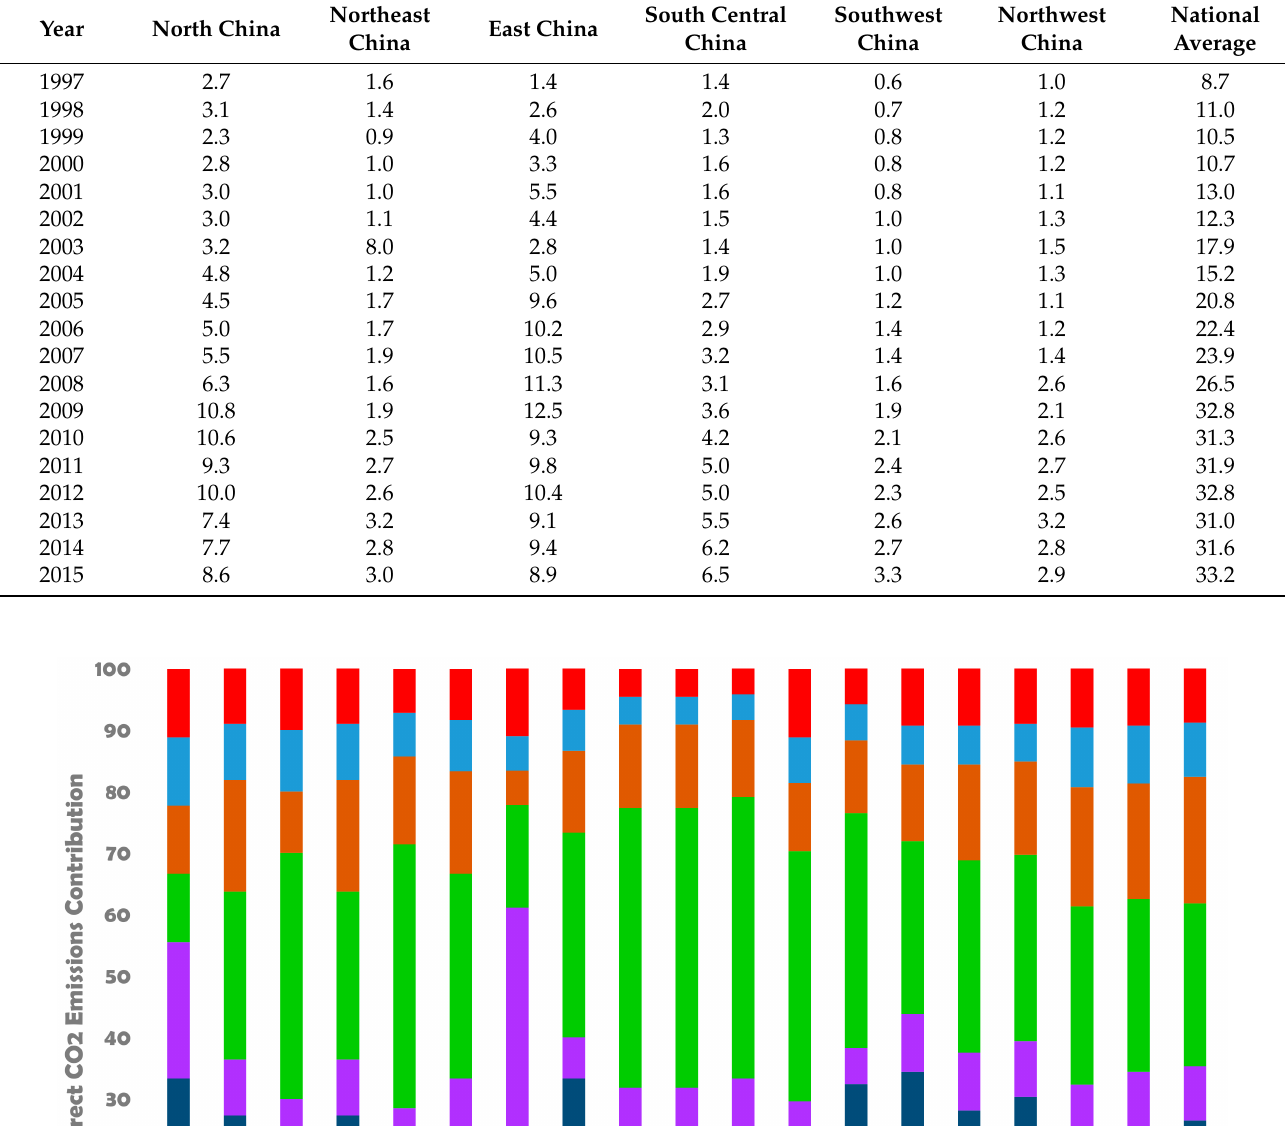
Table 6. Regional construction industries’ direct CO 2 emission inventories (MtCO 2 ).